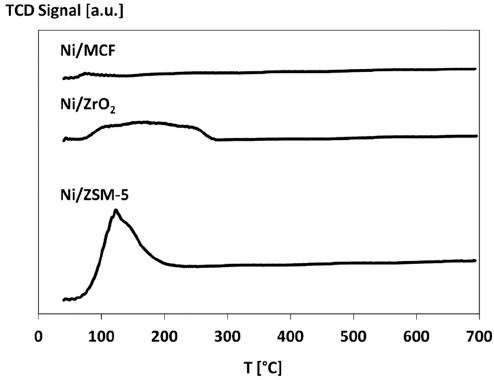
Figure 4. Temperature-programmed desorption (TPD)-NH 3 profiles of Ni catalysts.